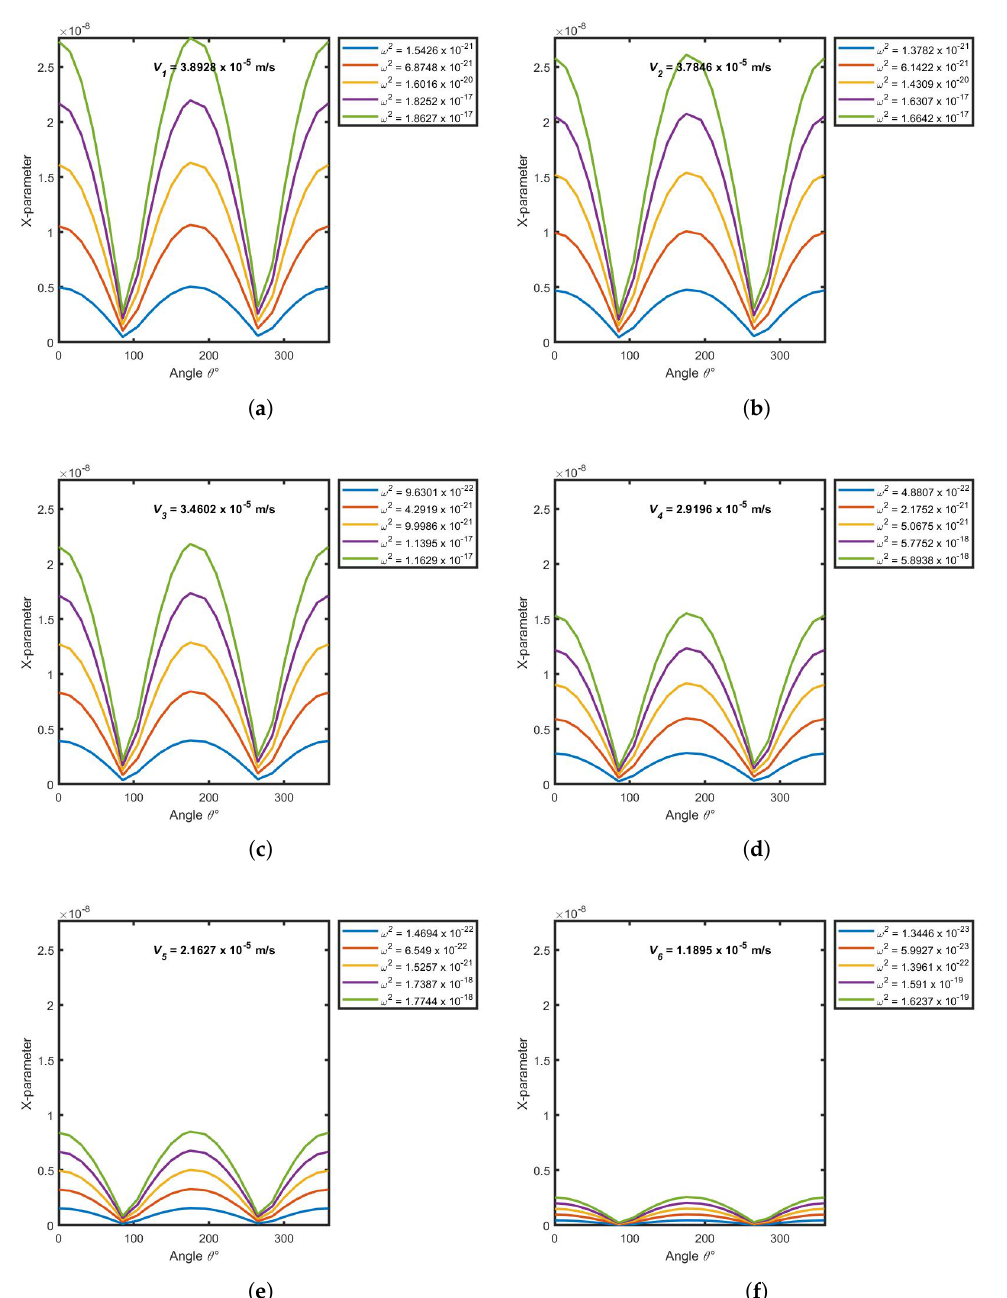
Figure 5. ( a – f ). X-parameter as a function of angle ( θ ) at a thickness of h = 1.7 × 10 − 5 m , time (cid:0) (cid:1) t = 10 d and varying separation constant ω 2 . For each channel thickness shown in Figure 3, eleven (11) symmetric velocity data points are generated, and each data point used in the computation of (cid:0) (cid:1) X p X-parameter profiles. Due to the symmetric nature of the velocity profiles, only half-wing of the plane; consisting of six (6) data points, is presented here. The data for the other half-wing is presented in Appendix